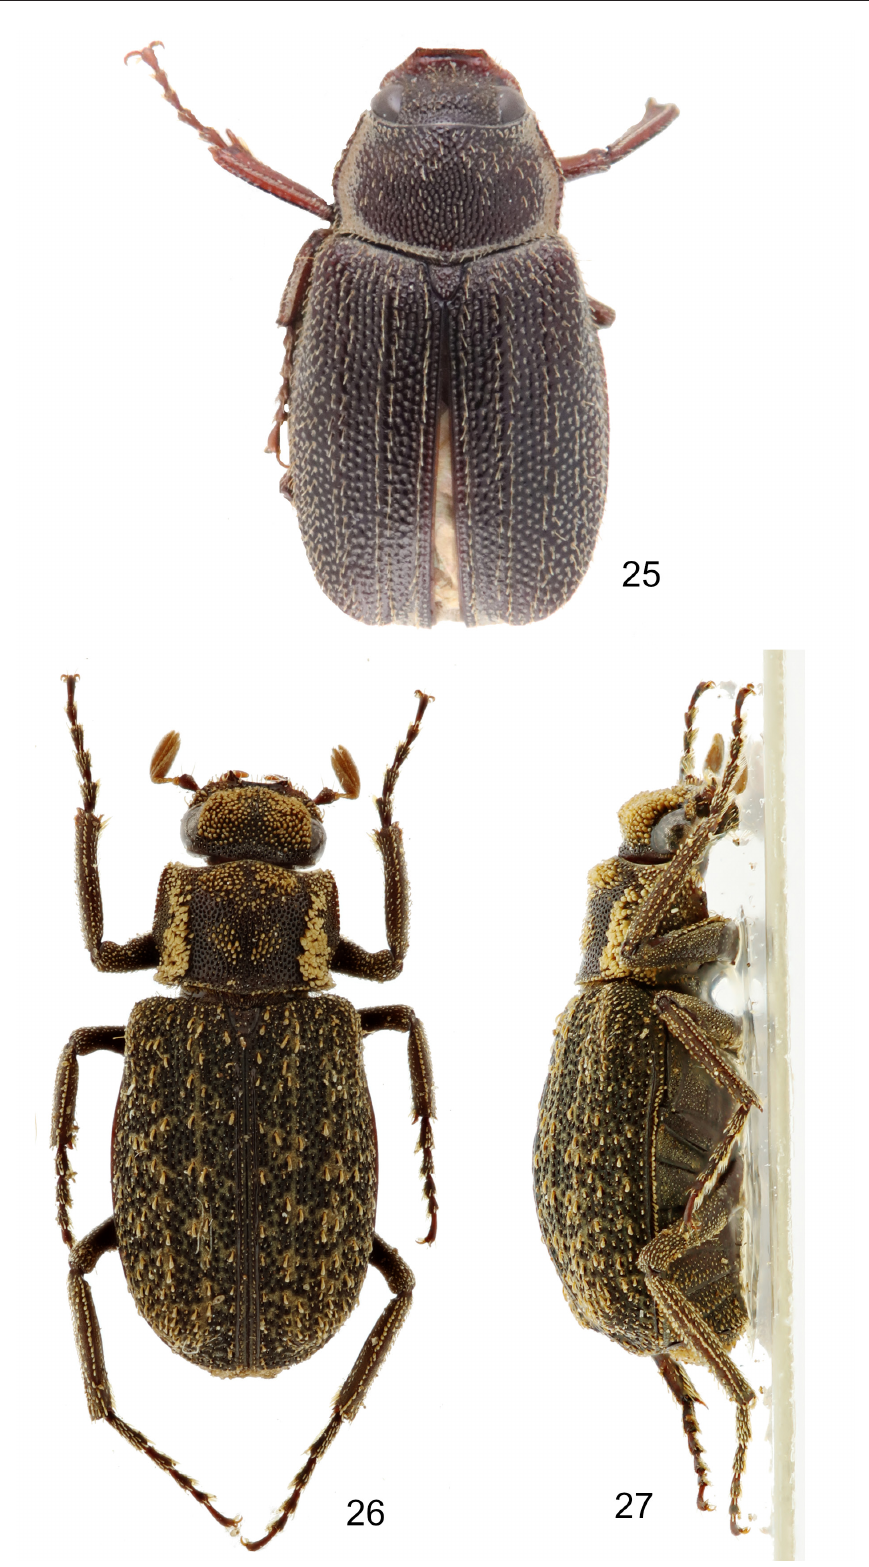
Figs 25–27. Papuan and Wallacean Maechidius Macleay, 1819, habitus, dorsal and lateral views. 25 . M. babyrousa sp. nov., holotype, ♂ (BMNH). 26–27 . M. bintang sp. nov., holotype, ♂ (NME). Not to